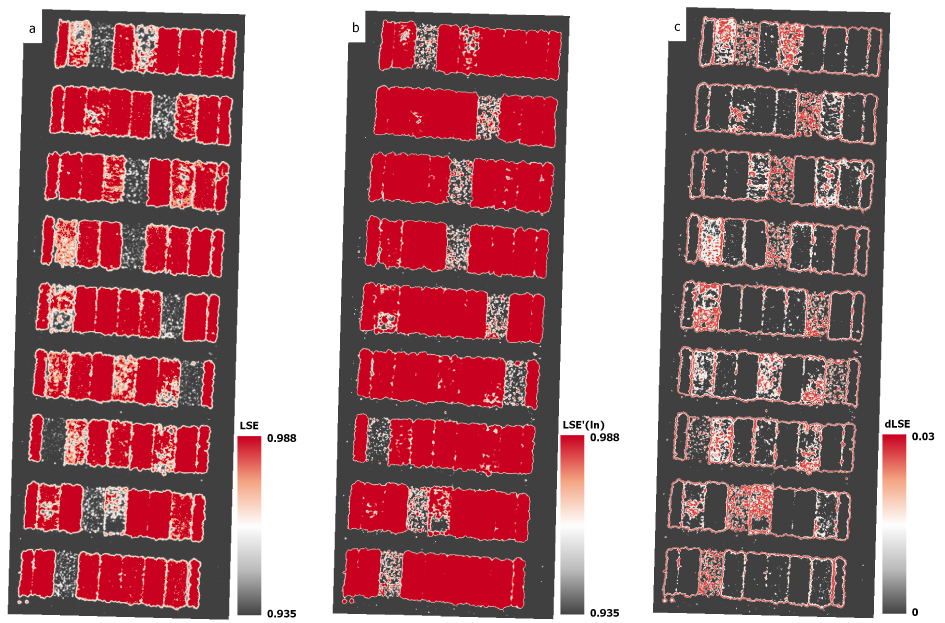
Figure 6. The LSE map ( a ) represents the emissivity considering P v ; whereas the LSE’ map ( b ) depicts the emissivity derived by the logarithmic relationship. The dLSE map ( c ) accentuates the selectivity of both